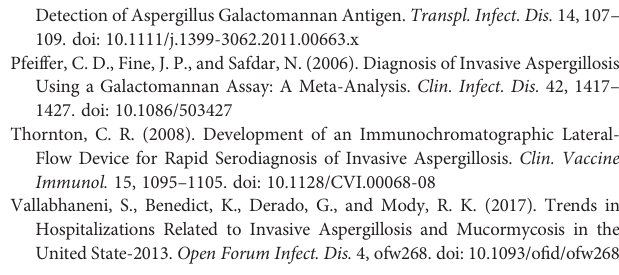
TABLE 1 | Clinical performance of the VIDAS ® GM and the Platelia ™ Aspergillus Ag assays using ROC analyses and best Youden index and serum samples of patients at risk for invasive aspergillosis. All sera (n = 126) VIDAS ® GM Platelia ™ Aspergillus Ag cut-off close to 0.5